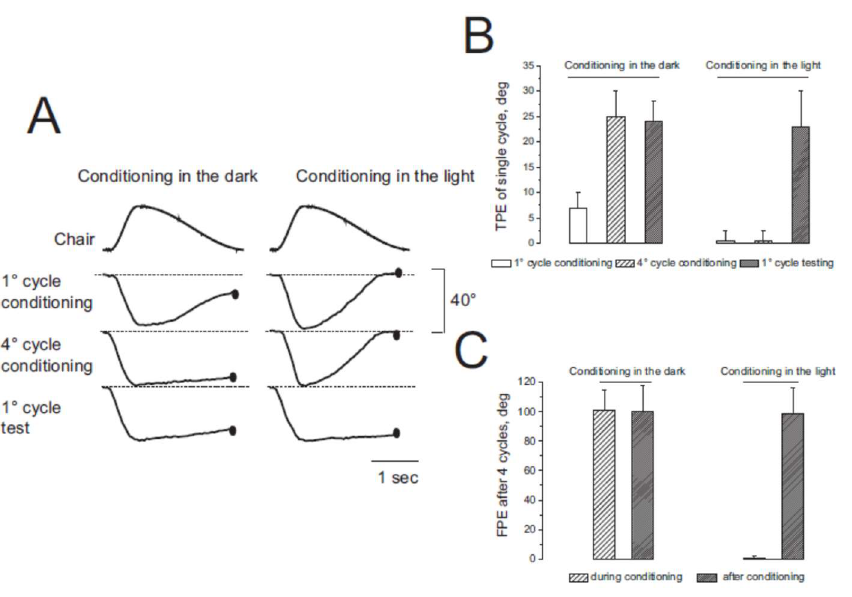
Figure 4. Tracking of the visual and remembered target. ( A ) Left and right columns show the single cycle response to conditioning in the dark and, respectively (session 1 and 2) (the lines indicate the experimental light condition). The distance between tracking at the end of rotation (black spot) and position of tracking before rotation is the tracking position error (TPE). ( B ) TPE of the response to a single cycle (1°, 4° conditioning cycle, and 1° test cycle). ( C ) FPE of the response to four cycles. In B and C, data in the left graph are from conditioning in the dark and those in the right graph are from conditioning in the light. Columns represent the mean and SD of errors of 12 individuals.